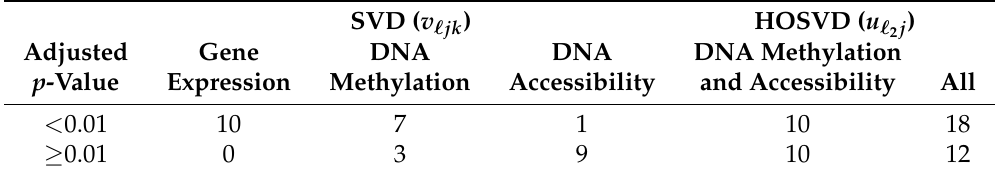
Table 3. Number of singular-value vectors coincident with classification shown in Table